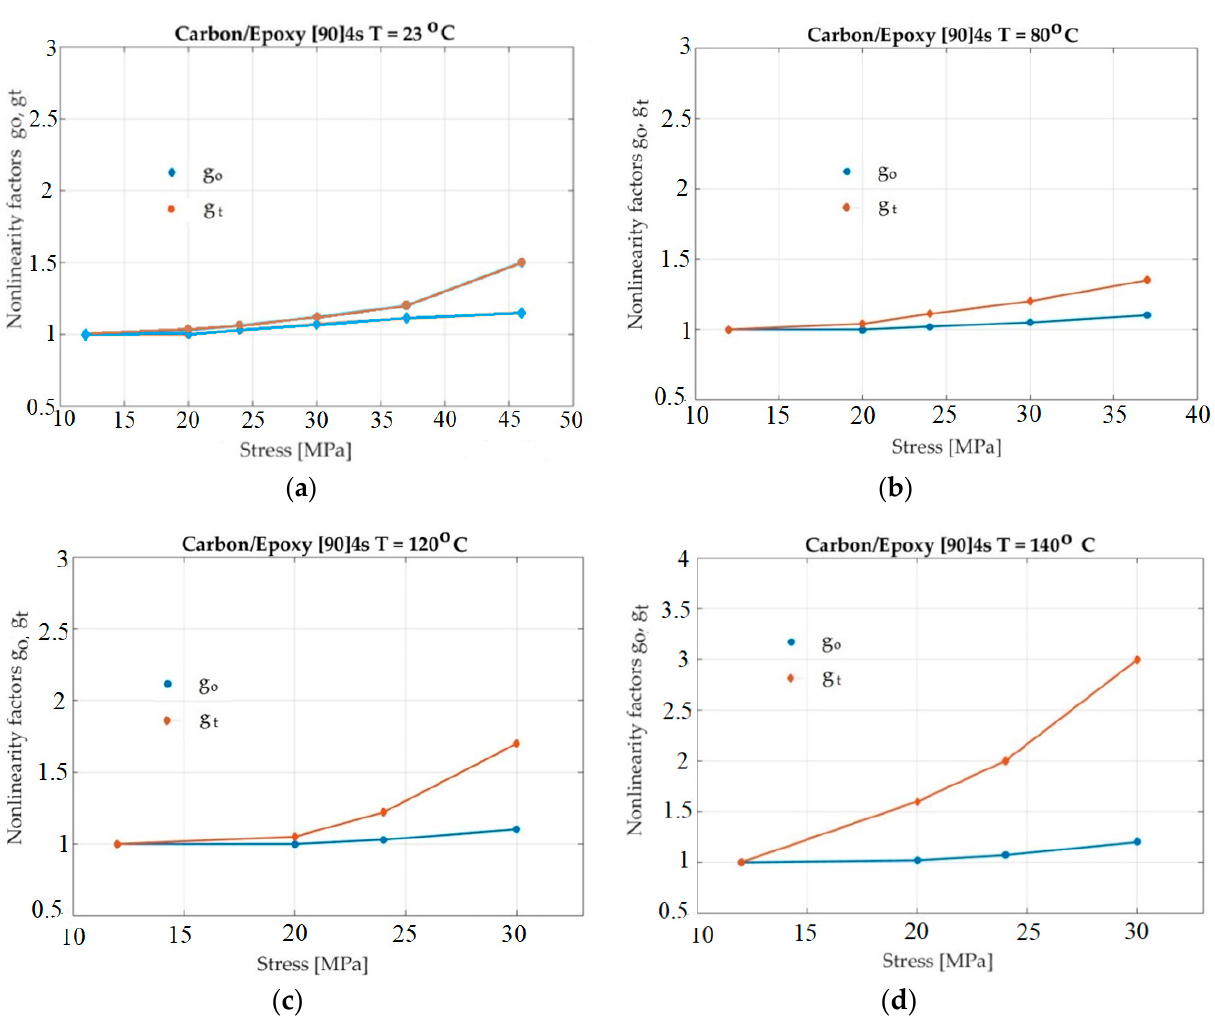
Figure 7. Plot of g o and g t for Carbon/Epoxy resin as a function of stress and temperature: ( a )—T = 23 °C; ( b )—T = 80 °C;